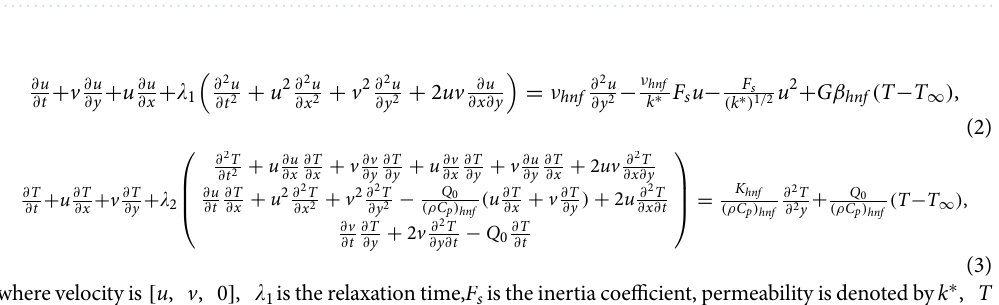
Table 1. Thermal properties 37,38 for silver, ethylene glycol and molybdenum disulfide.